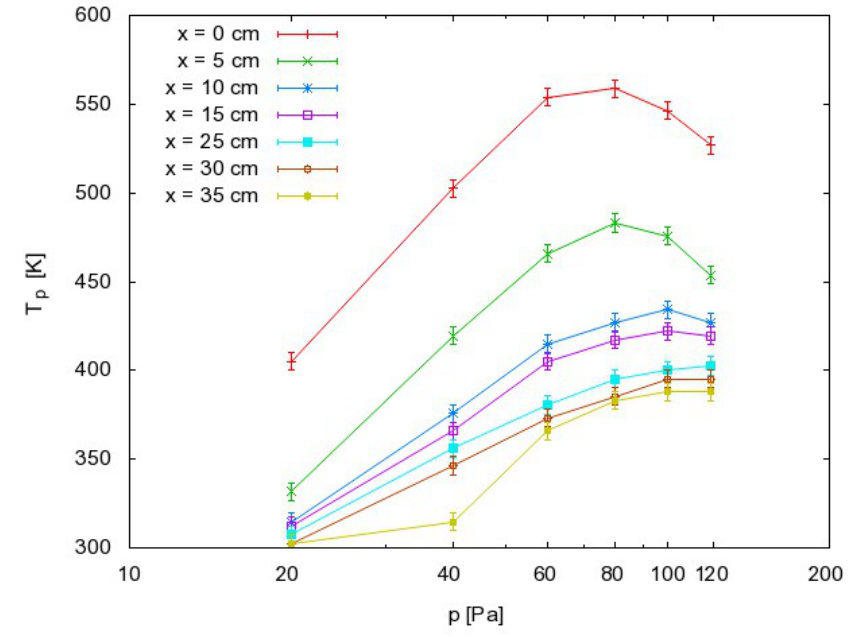
Figure 4. Maximum temperature of a nickel catalyst versus pressure with the catalytic probe at different positions in the afterglow chamber. Absolute error is about ≈ 5 K due to instrument (voltmeter)